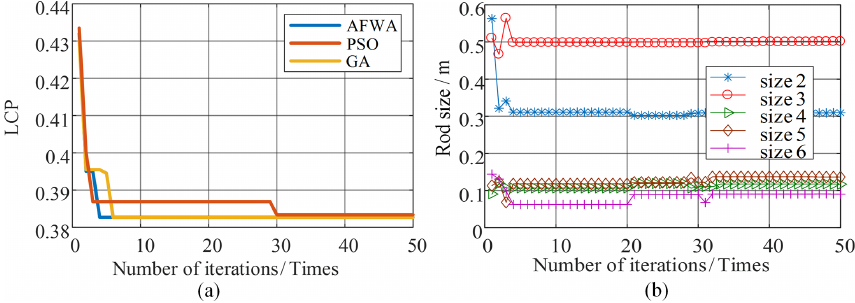
Figure 10. Particle evolution diagram with LCP as optimization target. (a) LCP index evolution diagram. (b) Particle evolution diagram for each link